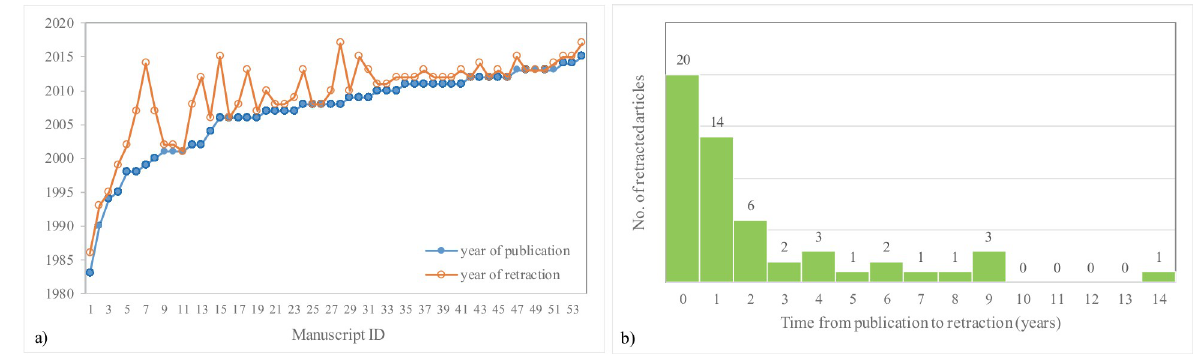
Fig 2. Retractions trends. a) Year of publication and year of retraction; b) The number of years from publication to retraction. Zero in graph b) means that the article was retracted in the first 12 months after publication.